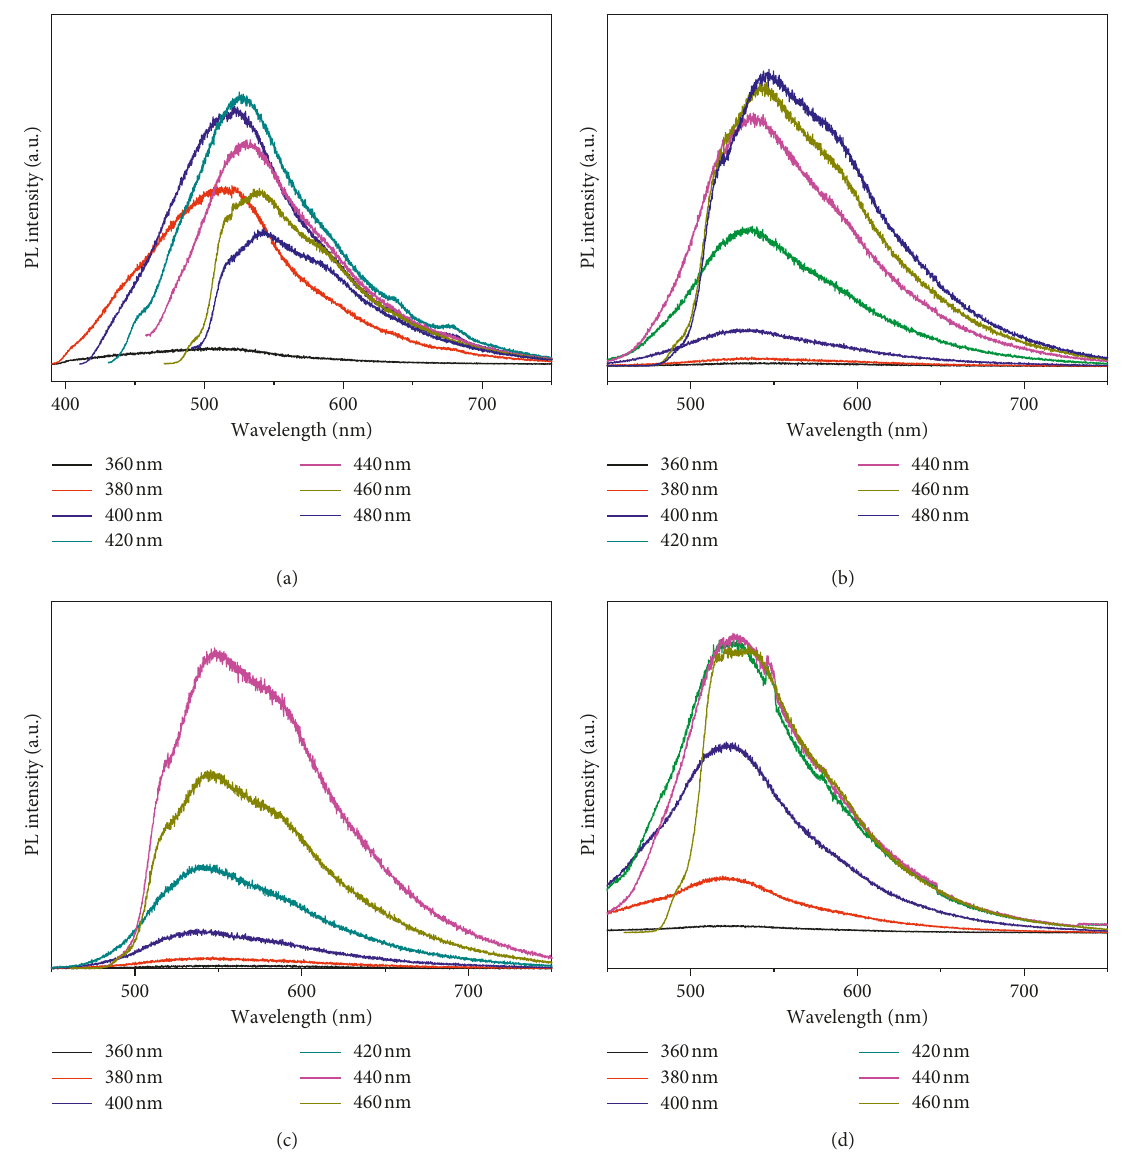
Figure 9: PL spectra of C-dots synthesized at different temperatures monitored by various excitation wavelengths: (a) 120 ° C, (b) 150 ° C, (c) 200 ° C, and (d) 240 °